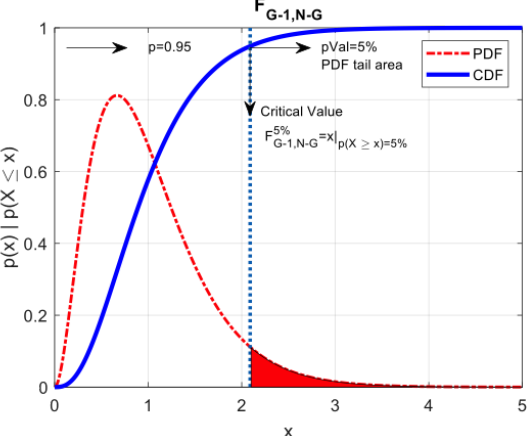
Figure 7. F ( G − 1, N − G ) distribution, with highlighted the 5% critical value and the concept of p